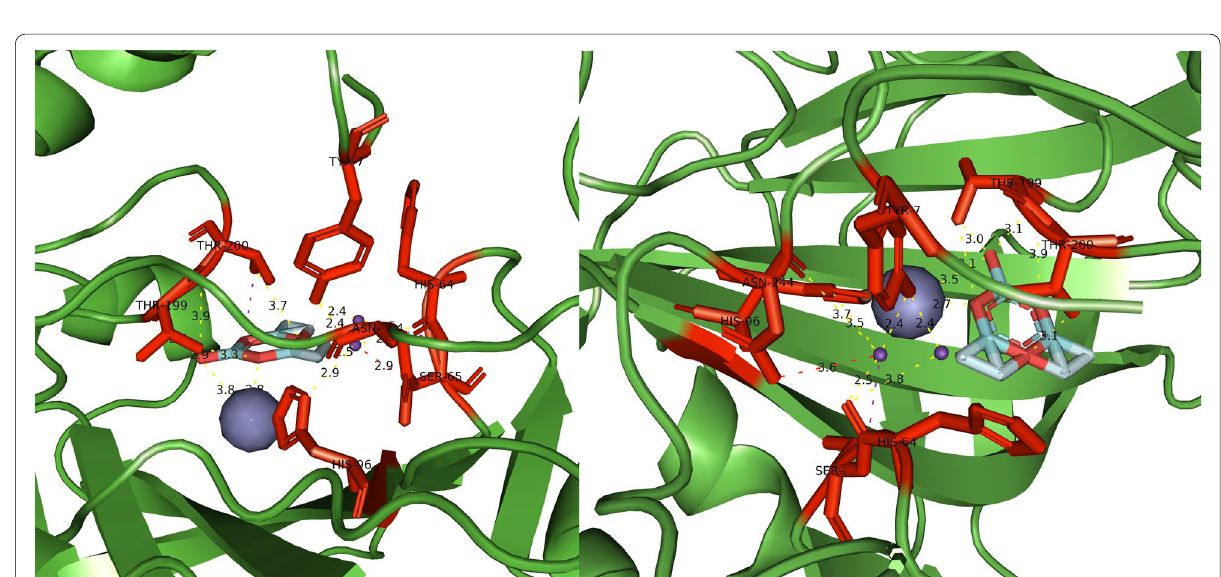
Fig. 10 Closer look at the interaction between HB and hCA IX for the first (left) and the second (right)